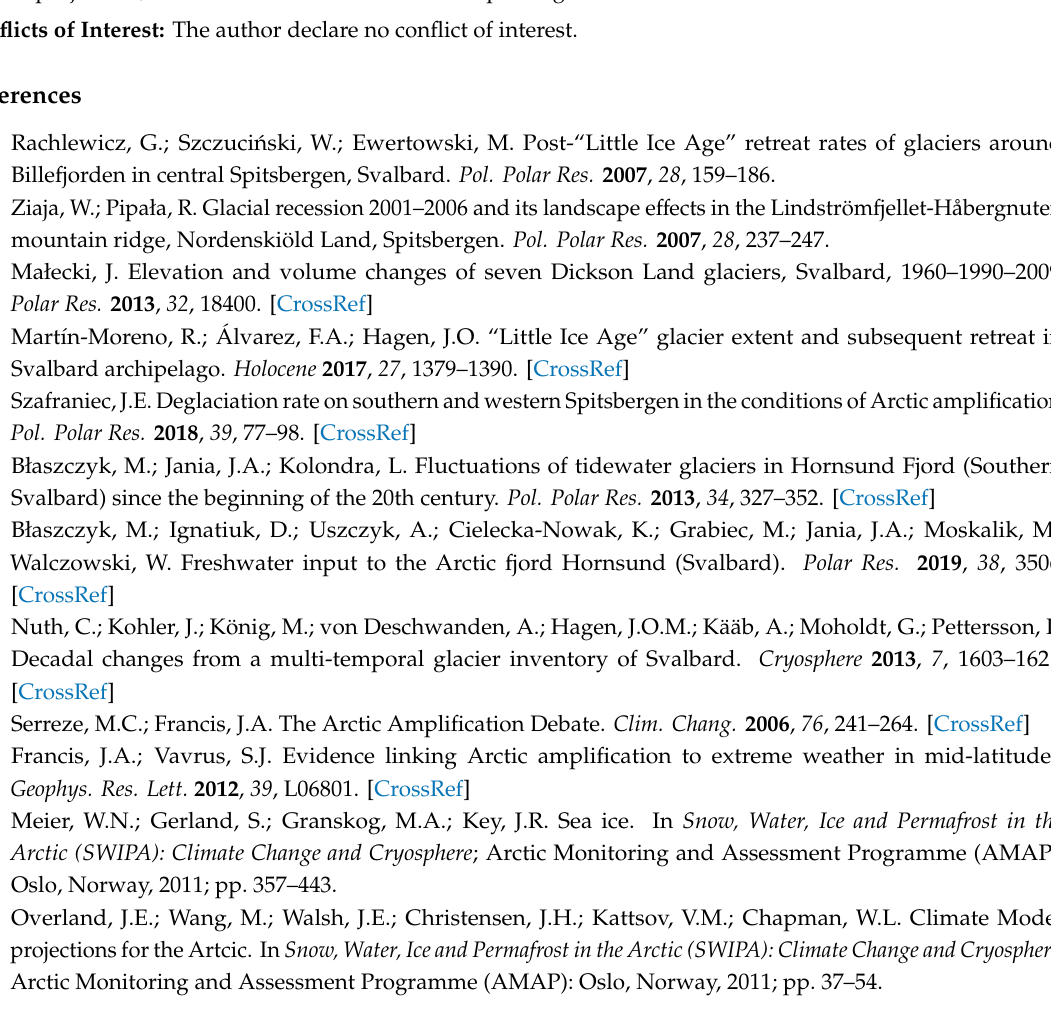
Table S1: Emblems of topographic maps and IDs and acquisition dates of Landsat satellite images used in the research; Table S2: IDs and acquisition dates of Landsat satellite images for selected tidewater glaciers in Spitsbergen in the period